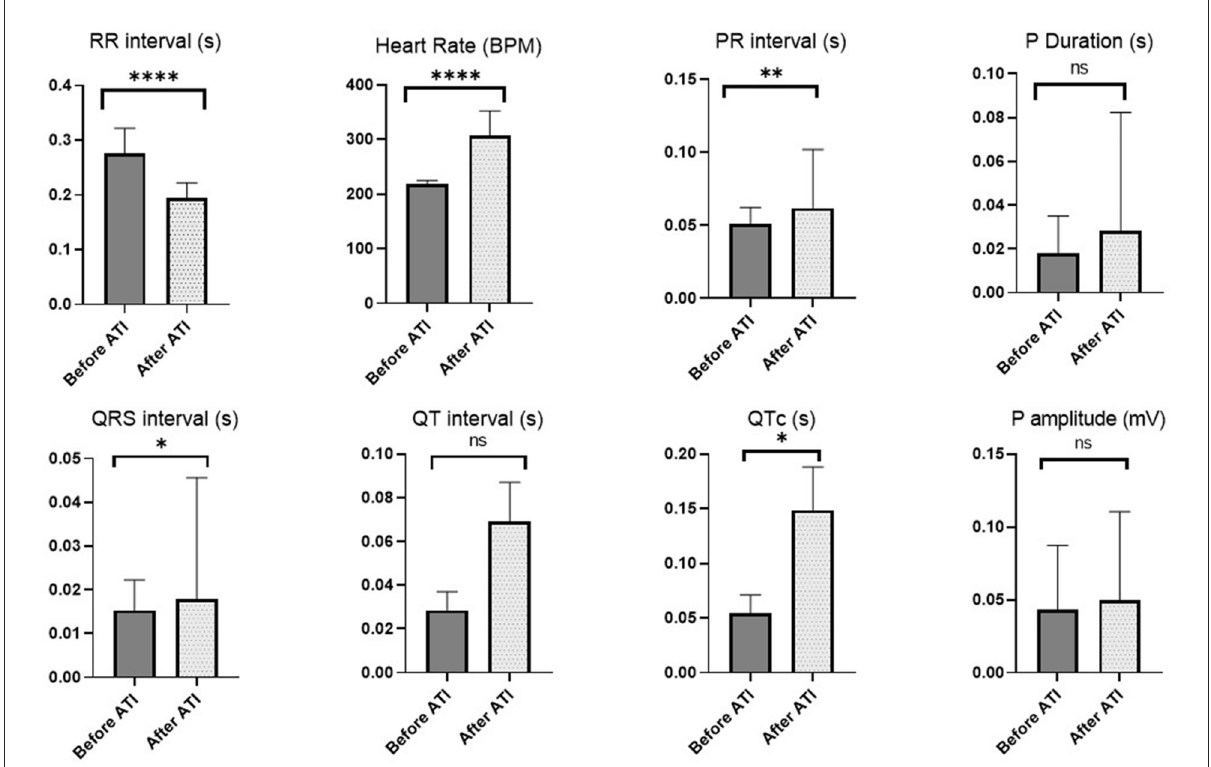
FIGURE3 Changes in ECG parameters before atipamezole (i.e., directly after MMB) and after atipamezole administration. Asterisk used to indicate the significance, Ns P > 0.05 , * P ≤ 0.05, ** P ≤ 0.01, **** P ≤ 0.0001.